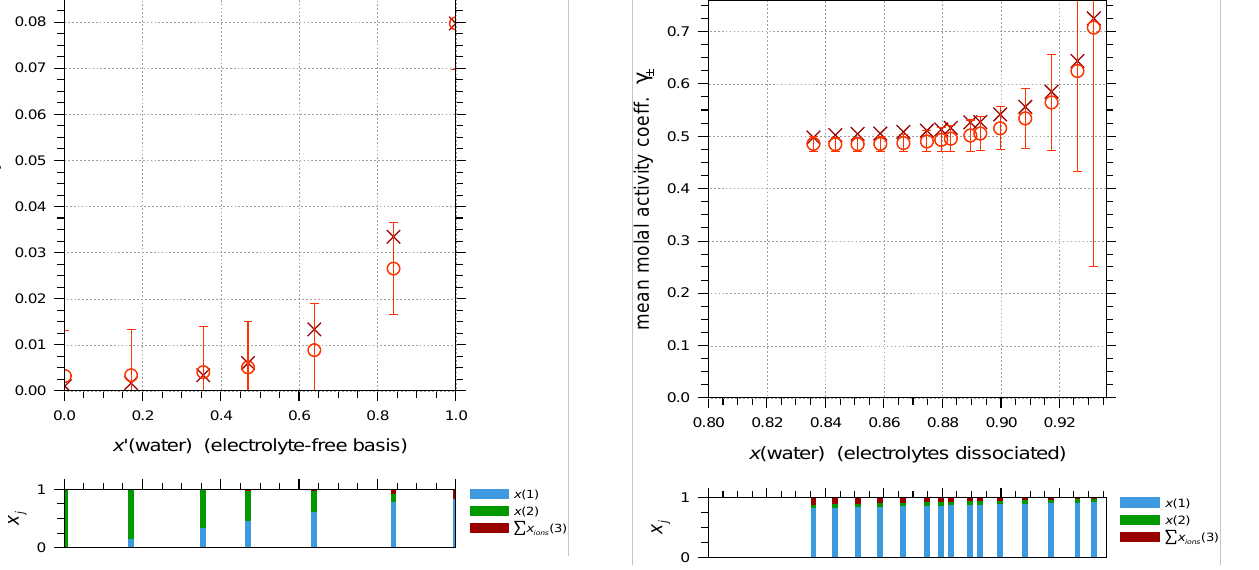
Fig. 6. Experimental and calculated SLE compositions of the sys- tem water (1) +2-ethoxyethanol (2)+KCl (3) at 298K, saturated with KCl. SLE composition measurements ( ) by Chiavone-Filho and Rasmussen (1993) and calculated solubility limits ( ) using the IAP KCl of the saturated binary water+KCl solution as reference. Error bars represent x tol = 0 . 01.